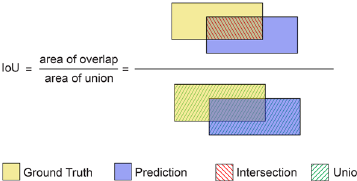
Fig. 11 De fi nition of intersection over union. Area of object intersection over the area of object union. This de fi nition is used to calculate precision and recall for a given IoU threshold.